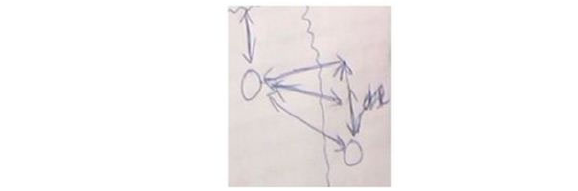
Figure 6. Kenneth’s graphical model-of the problem.